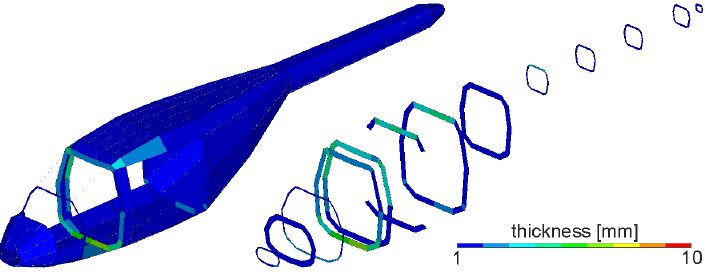
Figure 24. Thickness distributions.